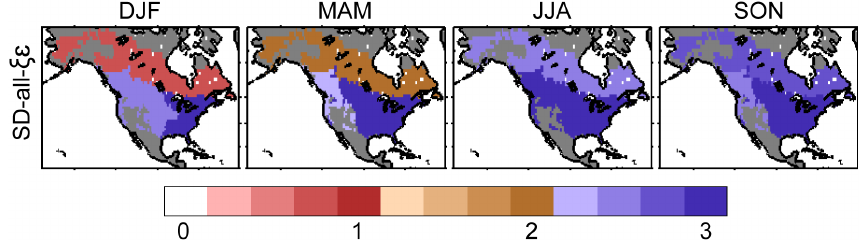
Figure 5. Average numbers of months within each season for which the candidate TBM is selected for the SD-all- ξε case study (Fig. 3). Grey shading represents biomes that were determined to be not sufficiently well constrained by available atmospheric data. DJF: December,